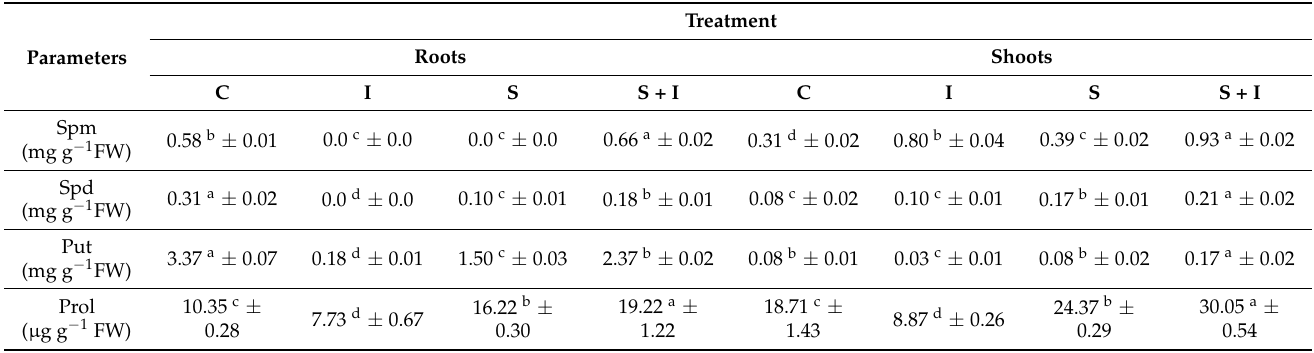
Table 3. Hormonal Status in Solanum melongena L. roots and shoots as affected by Salt Stress and/or inoculum